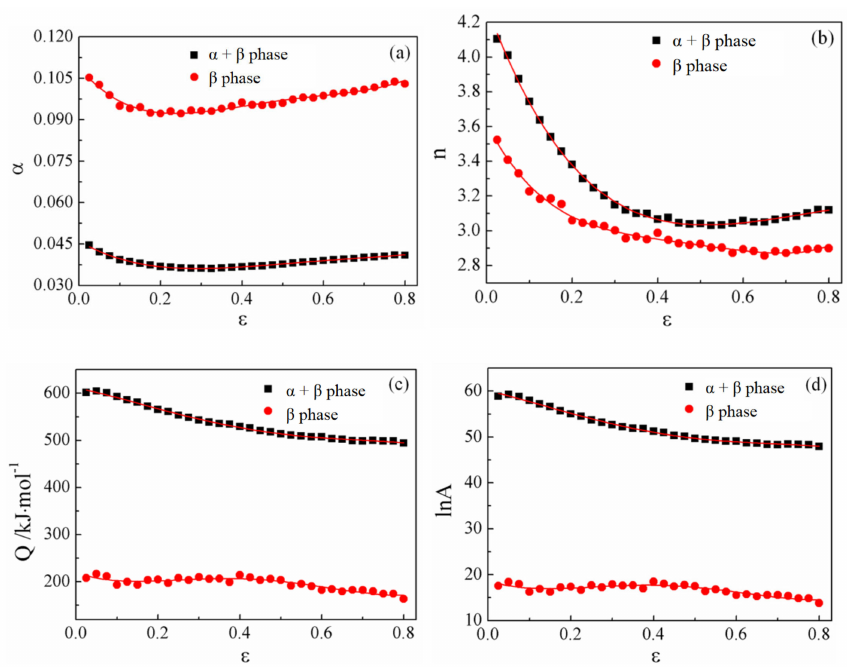
Figure 13. Relationships between ( a ) α , ( b ) n , ( c ) Q , and ( d ) ln A and true strain by polynomial fit of Ti-6.5Al-3.5Mo-1.5Zr-0.3Si titanium